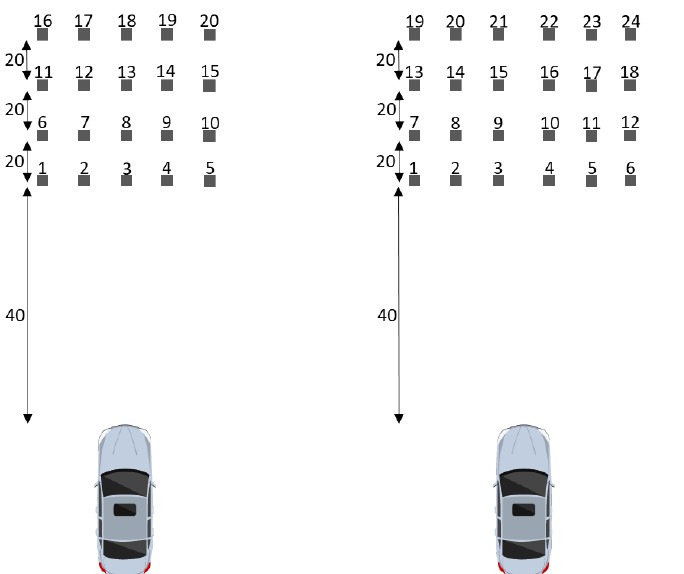
Figure 5. Schematic representation of the measurement grids for the detection studies in non-urban areas; in the light tunnel, a 4 × 5 measurement grid was realized ( left ), while on the closed test site a 4 × 6 measurement grid was achievable ( right ); the distances to the individual object rows were 40m, 60m, 80m and 100m; the numbers above the grid points indicate the internal designation of the respective object position.